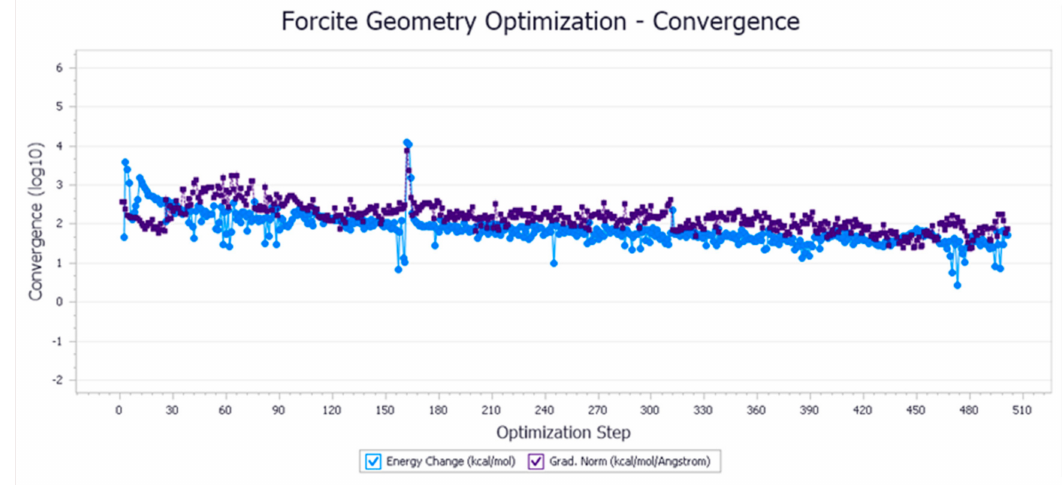
Figure 9. Demulsifier6 # oil–water interface geometric optimization